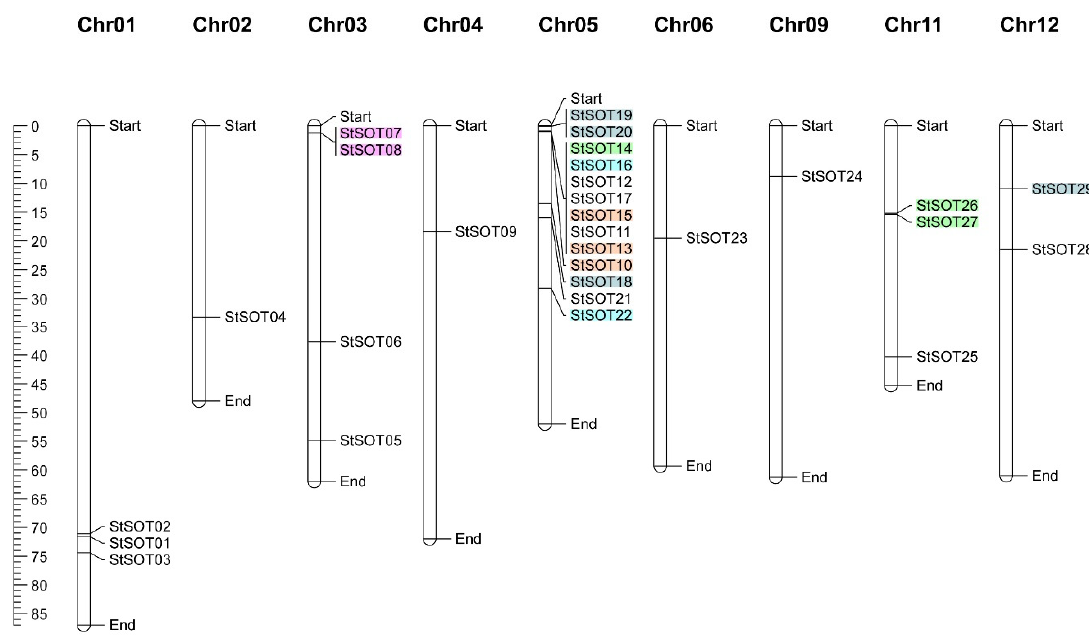
Figure 4. Chromosomal map of StSOT family genes in the potato genome. Five series of duplicated/triplicated StSOTs are indicated in different colors. The scale is in mega bases. Table 2. Duplicated gene pairs in the StSOT gene family and Ka / Ks analysis. Multiple duplication/triplication events were identified in five categories (in different colors in the chromosomal map in Figure 4). Duplicated Gene